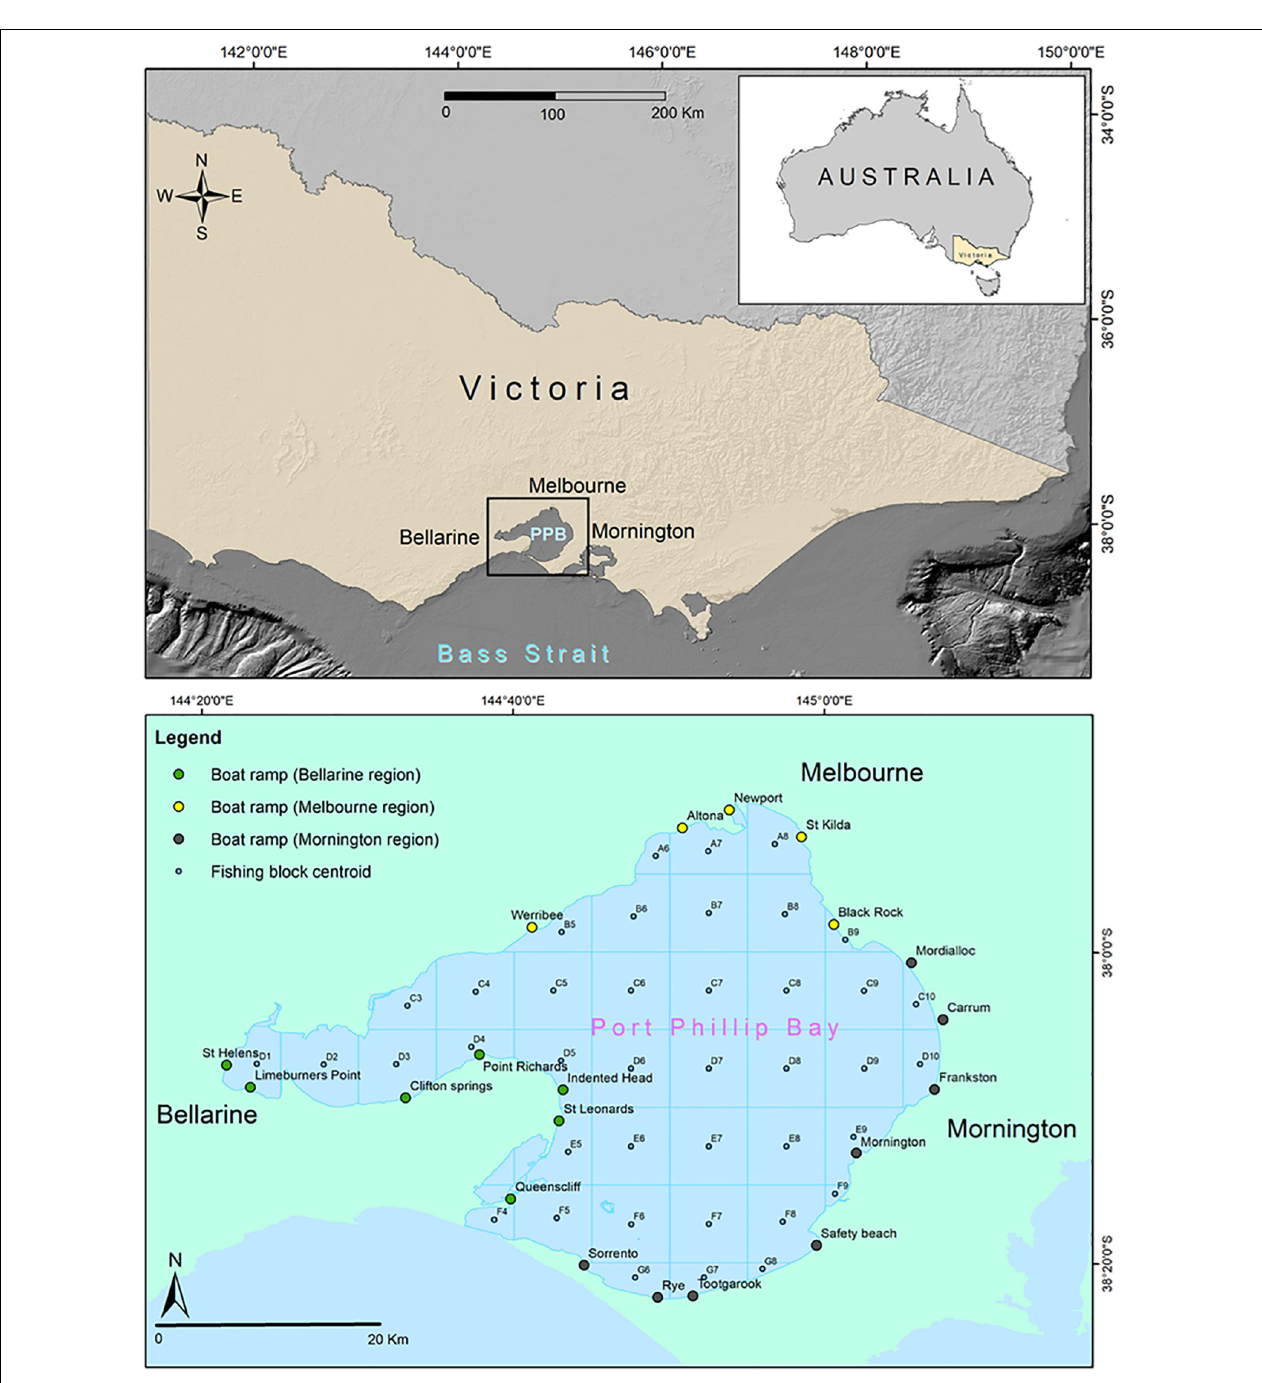
FIGURE 1 | Map of the study area overlaid across the shaded relief of land and sea, zoomed over the State of Victoria and Port Phillip Bay in the lower panel showing the three residential regions of Bellarine, Melbourne and Mornington. Fishing block codes and boat ramp names are also